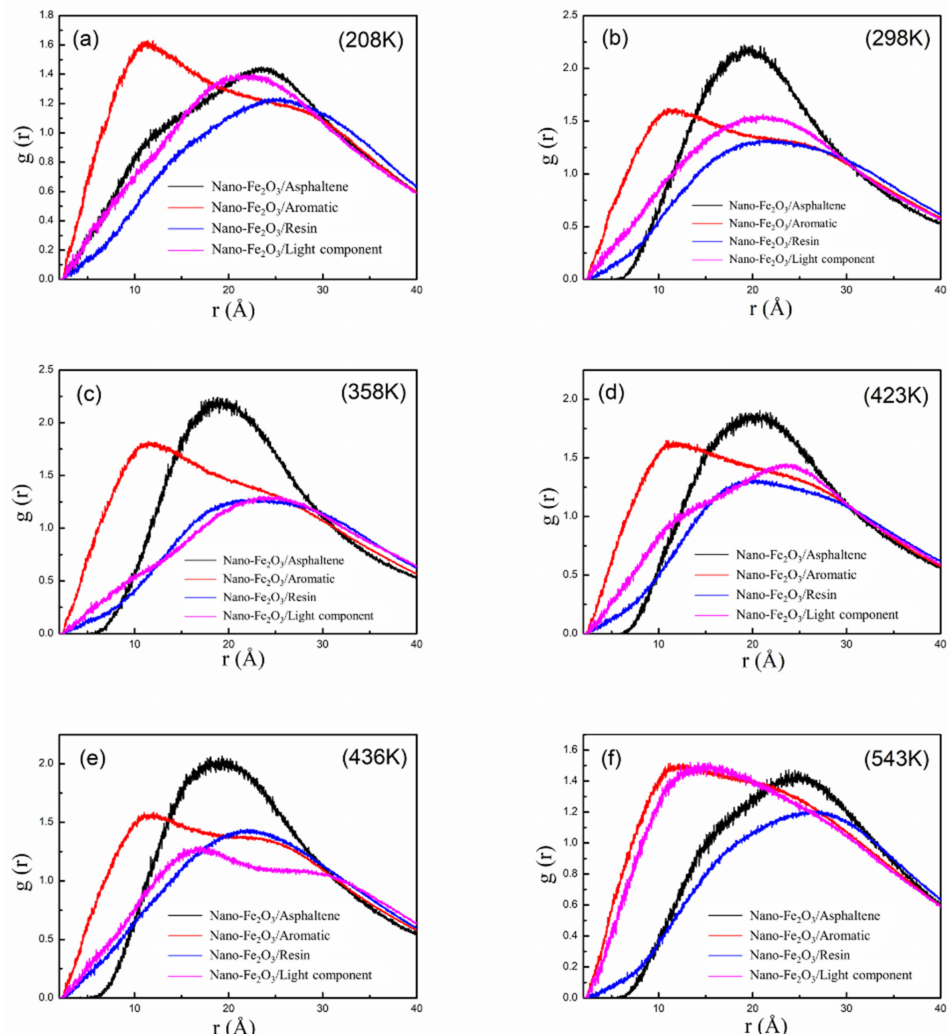
Figure 6. RDF between Nano-Fe 2 O 3 and asphalt components in Nano-Fe 2 O 3 /asphalt composite system. Figures ( a – f ) are RDF curves at different